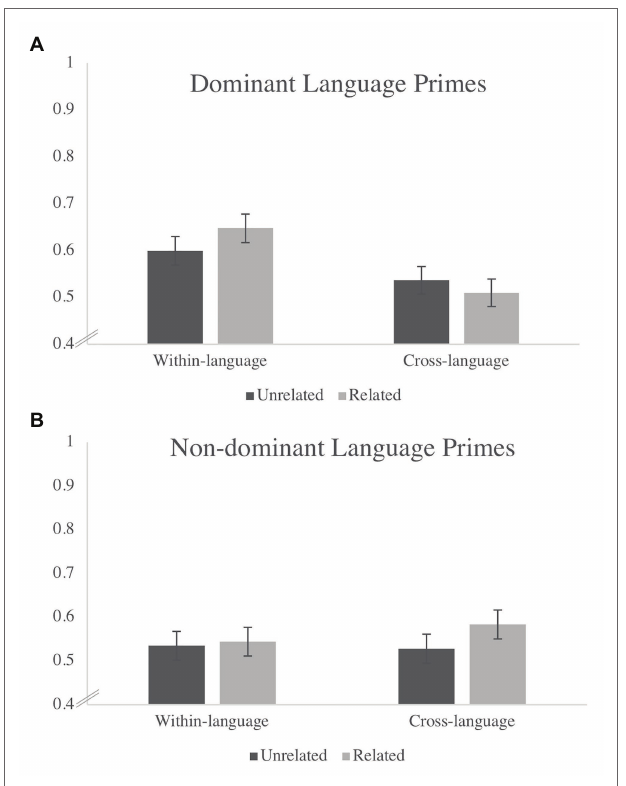
FIGURE 4 | Average proportion of time spent looking at the target across related and unrelated trials at 24 months when primes were in the (A) dominant language compared to the (B) non-dominant language across within- and cross-language